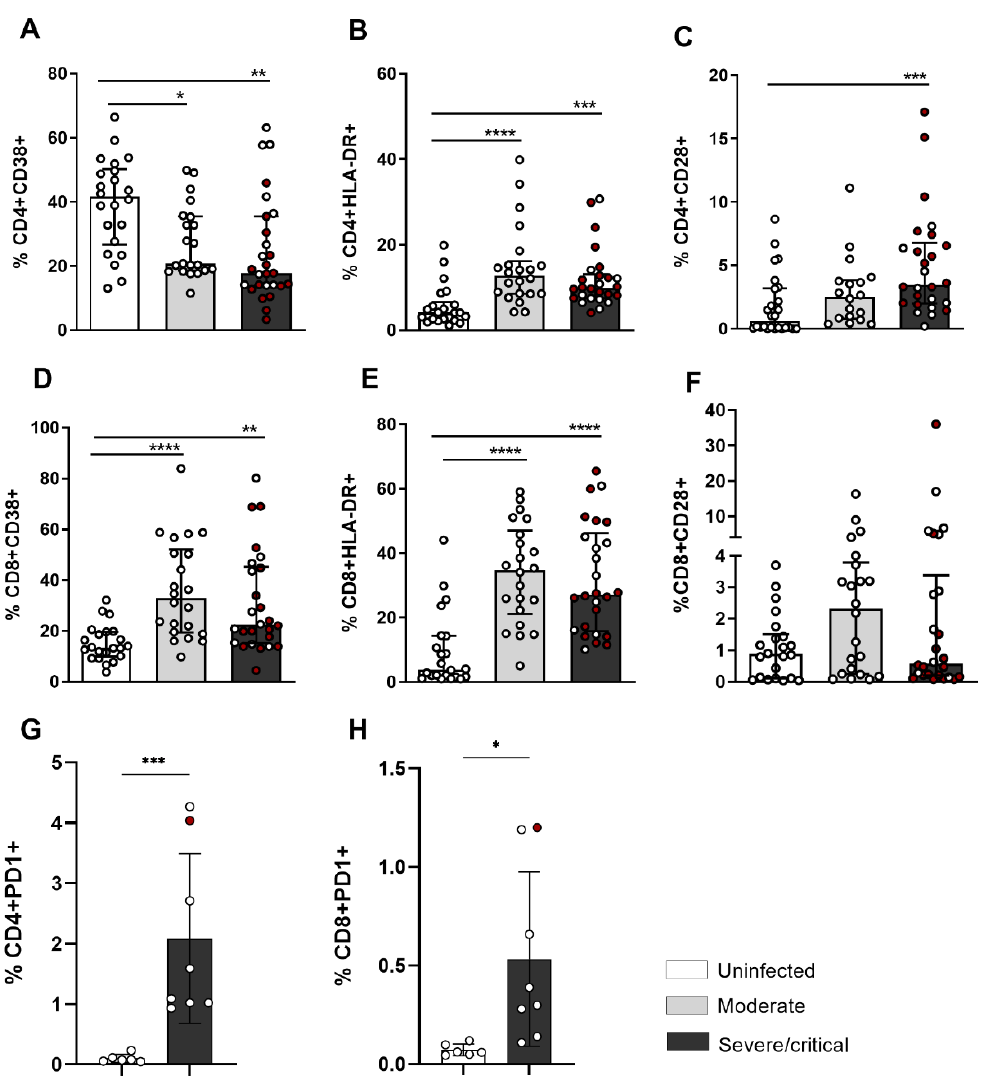
Figure 3. Increased frequency of activation markers and PD-1 expression of CD4+ and CD8+ T lymphocytes of patients infected with SARS-CoV-2. Frequency in CD4+ T lymphocytes: ( A ) CD38+, ( B ) HLA-DR+, and ( C ) CD28+; frequency in CD8+ T lymphocytes of ( D ) CD38+, ( E ) HLA-DR+, and ( F ) CD28+; ( G ) frequency of PD-1 expression within total living cells of CD4+ T lymphocytes; ( H ) frequency of PD-1 expression of CD8+ T lymphocytes. The red dots represent patients with the critical infection. The bars represent the median and interquartile range. * p < 0.05, ** p < 0.01, *** p < 0.001, and **** p <